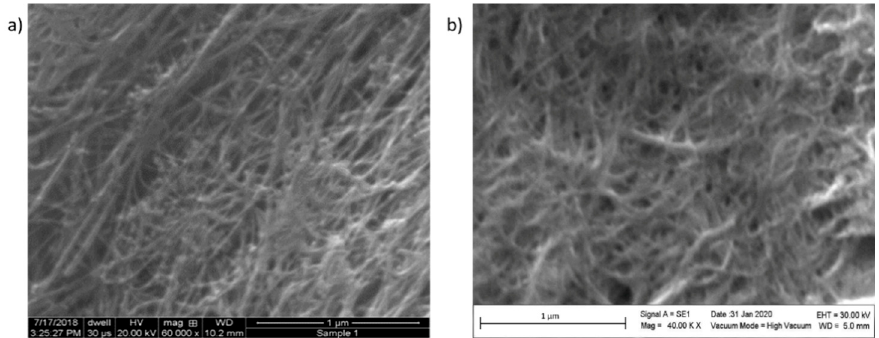
Figure 5. ( a ) MWCNT fiber surface taken at ×60,000 magnification and 10.2 mm working distance (WD) and ( b ) surface of a SWCNT buckypaper taken at ×40,000 magnification and 5 mm WD.